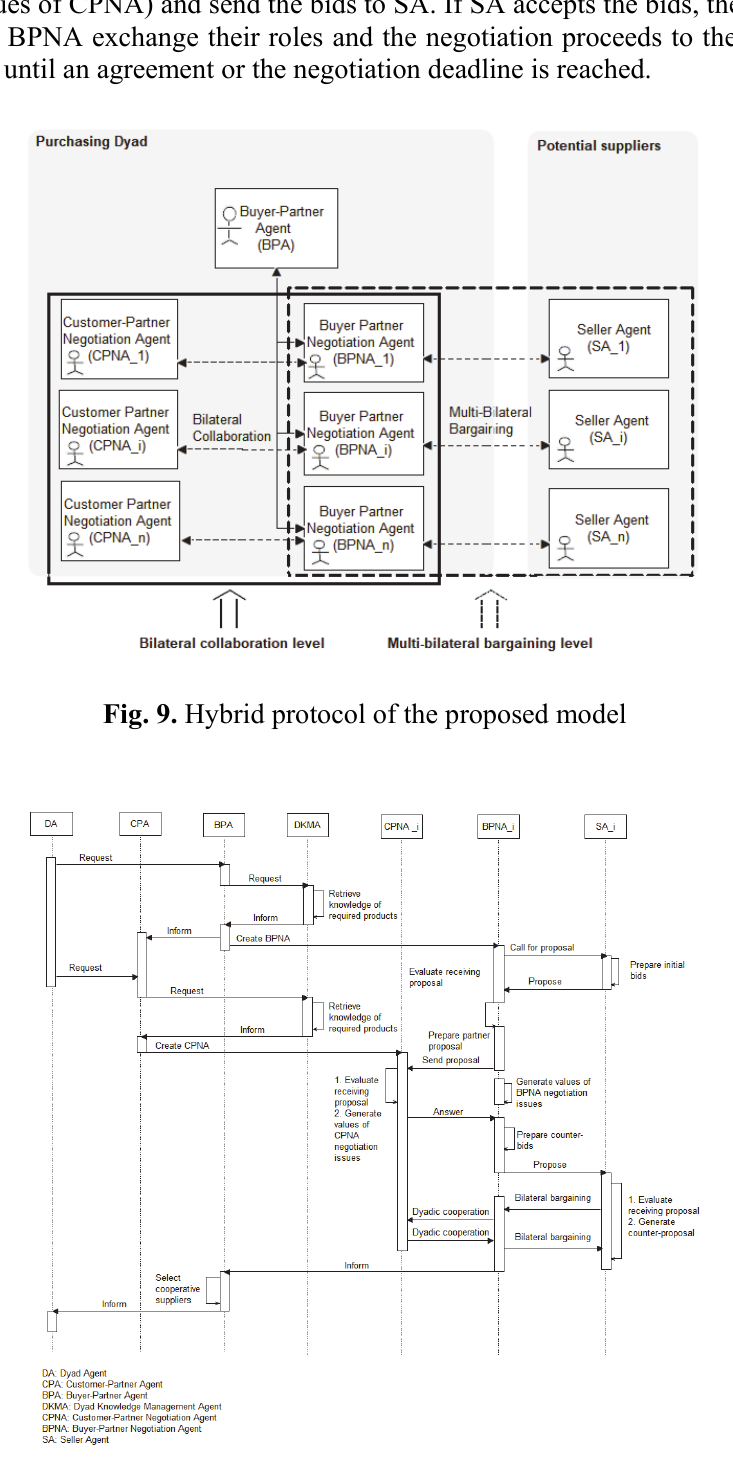
Fig. 10. Protocol diagram of information